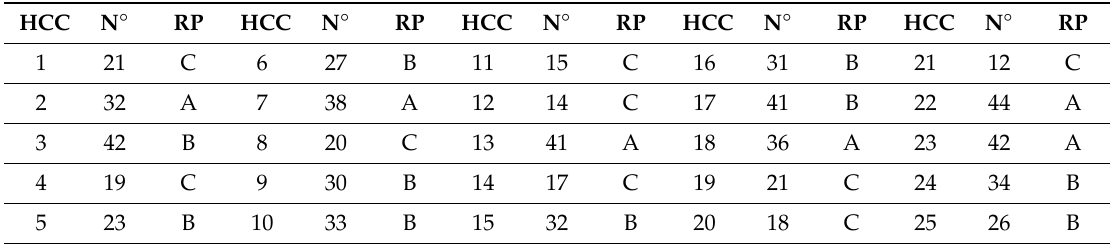
Table 3. Average monthly incidents of each healthcare center.